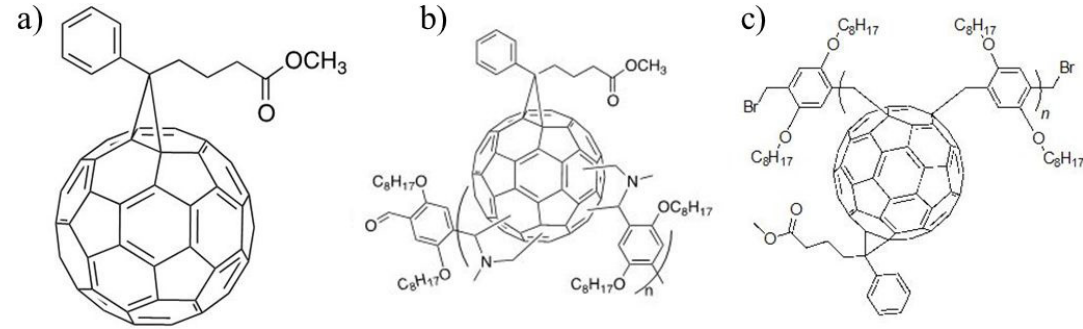
Figure 1. The modified fullerenes used in this study: a) PCBM, b) PPCBMB and c)